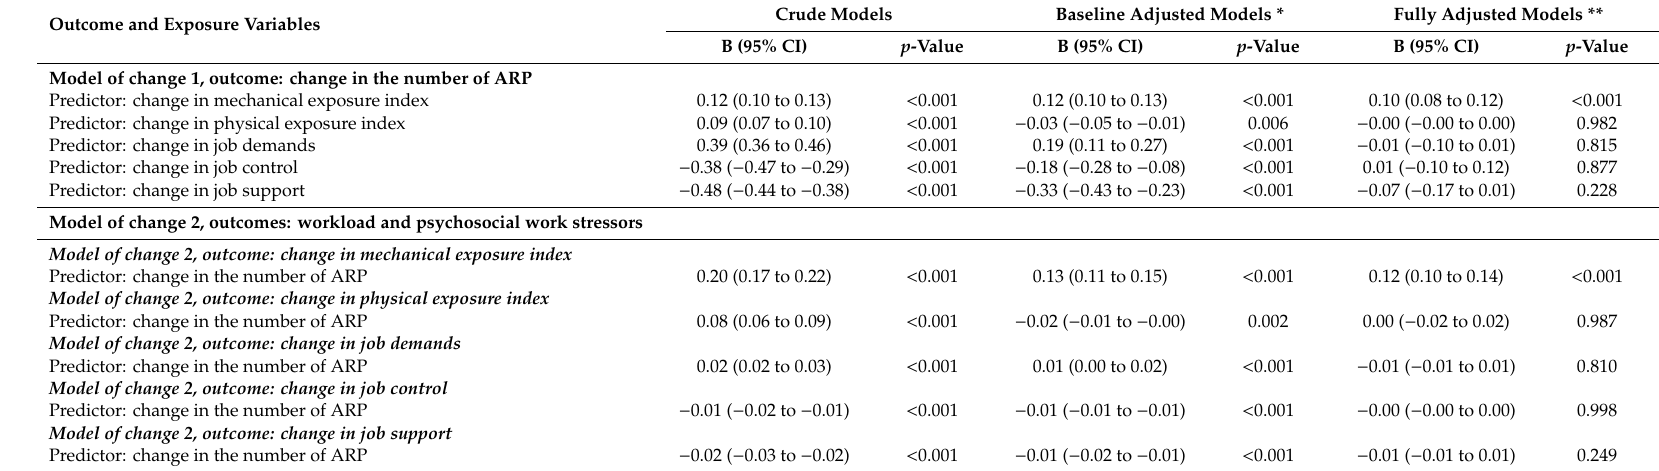
Table 6. Model of changes over time between workload, psychosocial work stressors, and the number of anatomical pain